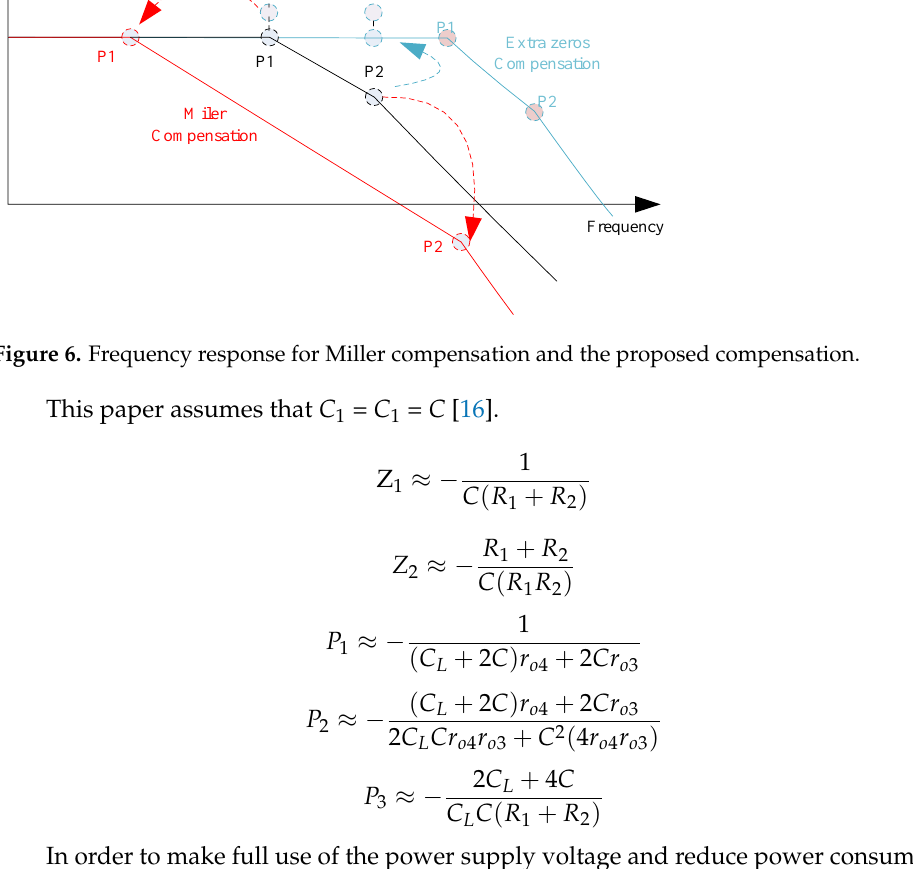
Figure 7. Circuit diagram of the linear amplifier. 2.2. The Switching Converter and the Hysteresis Comparator The hysteresis comparator plays an essential role in achieving high efficiency as shown in Figure 8. Hysteresis control has the advantages of fast response speed, no need for an additional stable compensation circuit, simple implementation, and a small area. By detecting the output current between the linear amplifier and the switching converter, the linear amplifier is indirectly controlled by the hysteresis comparator to generate addi- tional output current to offset the amplification error current that is generated by the switching converter.